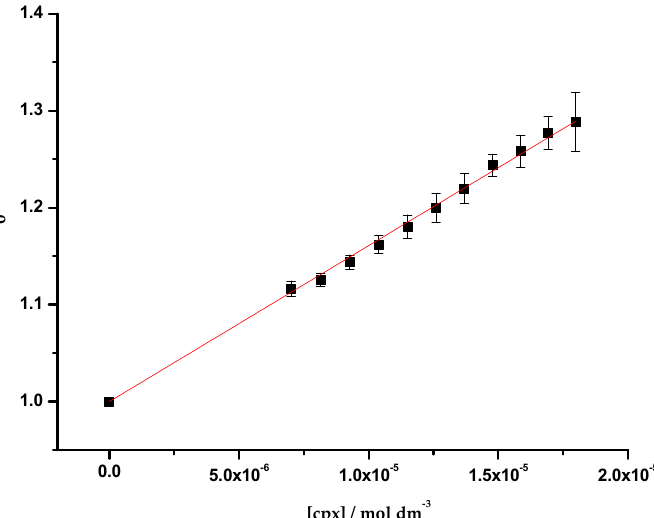
Figure 2. Plot of I 0 / I vs. cpx concentration ([cpx]), determined for OmpF WT/ E. coli total extract proteoliposomes. Equation (3) was fitted to the experimental data. Data points are the mean of, at least, three independent experiments. Error bars are the SD. Table 1. Values of the association constants ( K ass ) of cpx with OmpF proteoliposomes of POPE/POPG, POPE/POPG/CL and E. coli total lipid extract, obtained by steady-state fluorescence, using Equa- tion (3). The presented values are the mean of, at least, three independent experiments ( ±